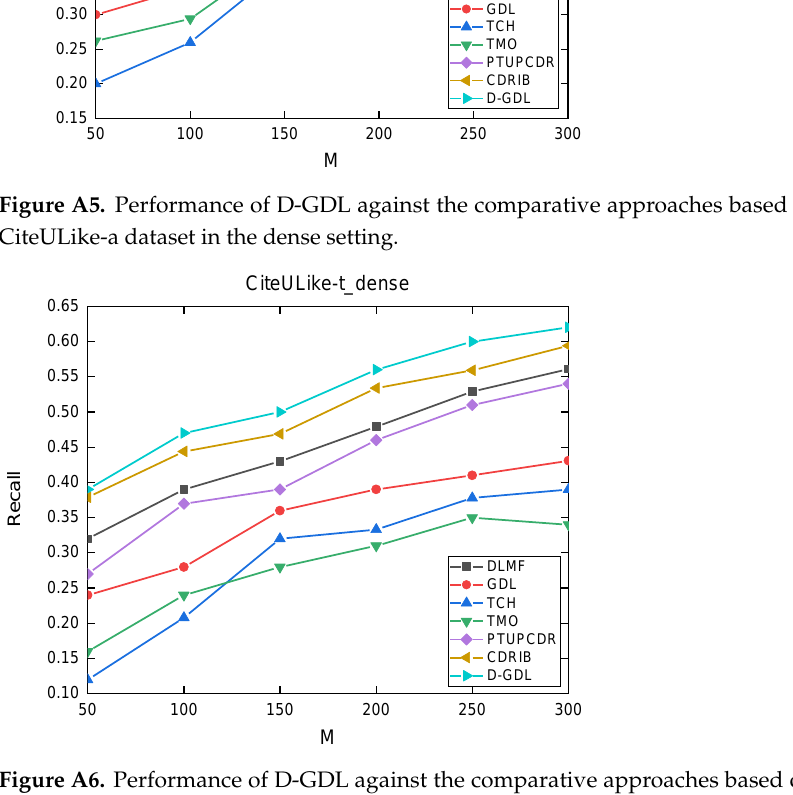
Figure A6. Performance of D-GDL against the comparative approaches based on Recall vs. M for CiteULike-t dataset in the dense setting.